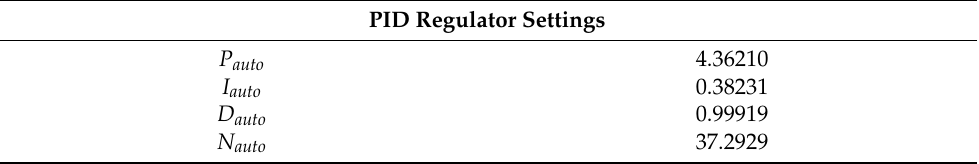
Table 2. PID regulator settings chosen with the auto-tuning method in